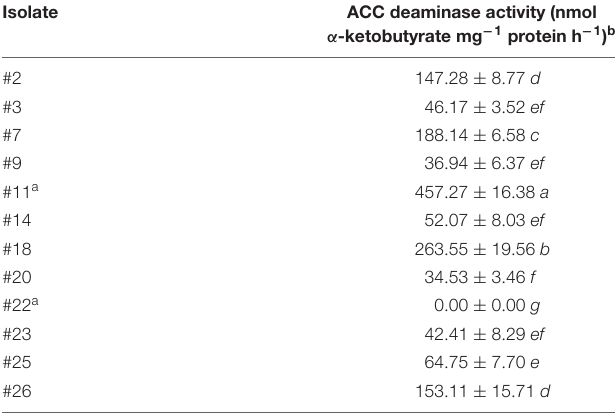
TABLE 1 | Production of 1-aminocyclopropane-1-carboxylic acid (ACC) deaminase by actinobacterial isolates grown in Dworkin and Foster’s salts minimal